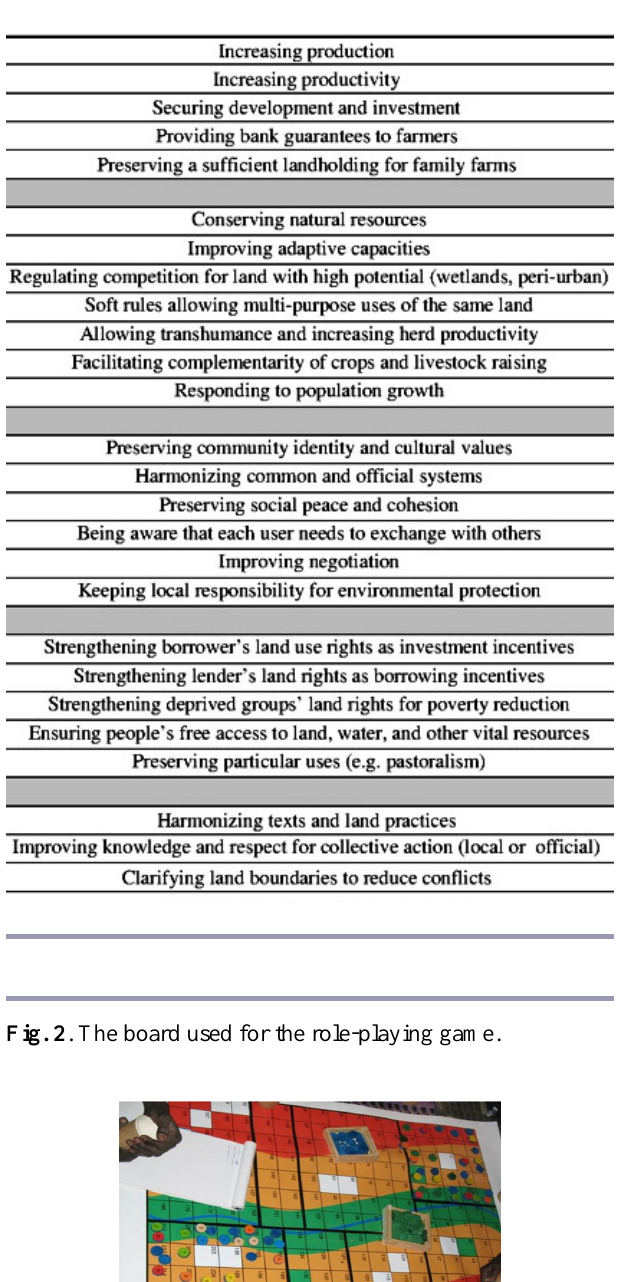
Fig. 1 . Some of the policy challenges that emerged from the self-eliciting workshops.